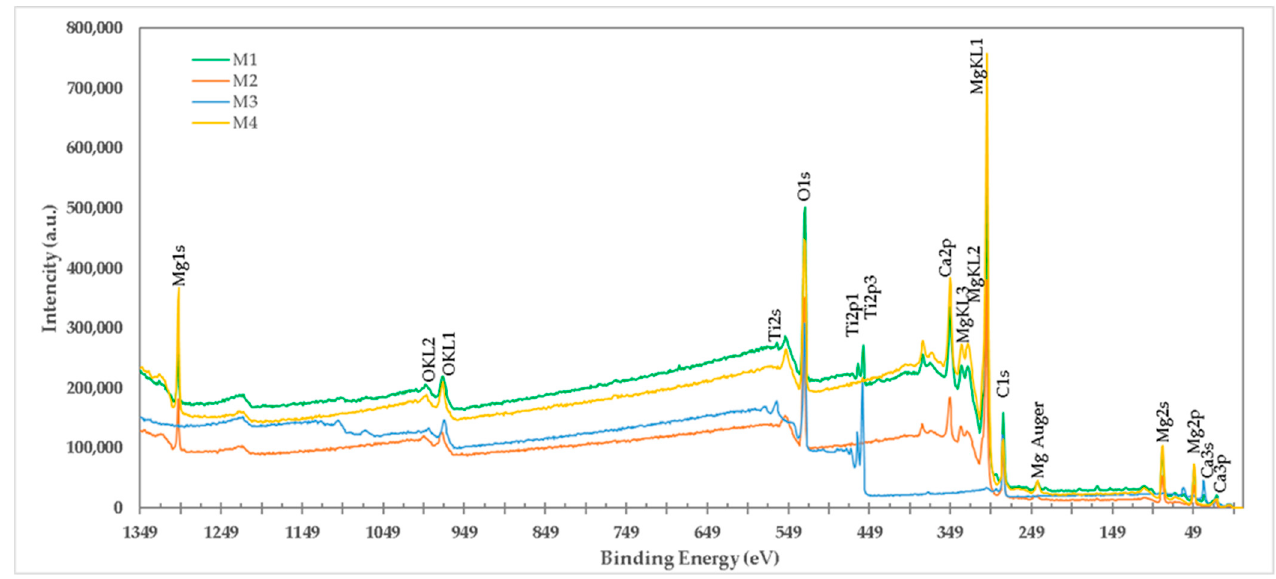
Figure 3. High-resolution spectrum of XPS of M1, M2, M3, and M4 formulations. For the M1 formulation (Brucite + TiO 2 treated at 1100 °C 1 h with final ratio 1:1 Molar of MgO:TiO 2 ), the presence of ions of Mg, Ti, Ca, and O was detected. For the M2 (calcined brucite at 1100 °C for 1 h) and M4 formulations (uncalcined brucite), the presence of Mg, Ca, and O ions was detected. For the M3 formulation (TiO 2 ), the presence of Ti and O ions was detected.